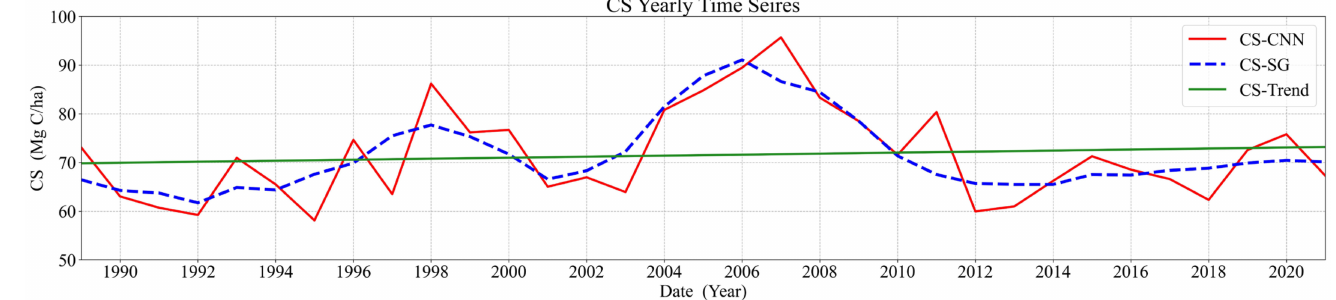
Figure 7. Time series average CS distribution trend, CS-CNN is the prediction curve of CNN model, CS-SG is the curve after the Savitzky–Golay filter smoothing curve, and CS-Trend is the overall development trend of